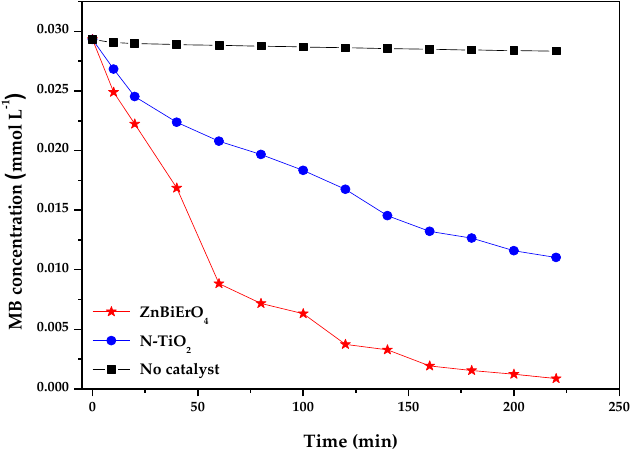
Figure 12. Photocatalytic degradation of methyl blue under visible light irradiation in the presence of ZnBiErO 4 and N-TiO 2 as well as in the absence of a photocatalyst.